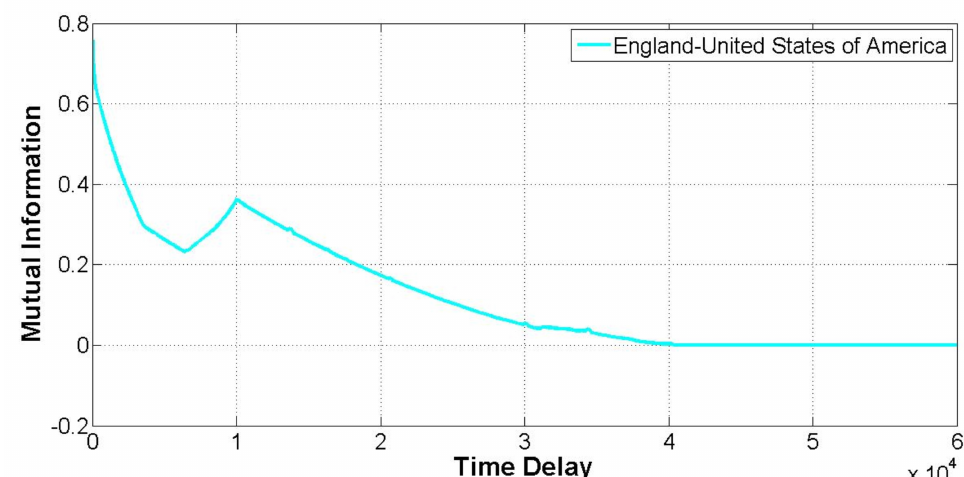
Figure 3. Time delayed mutual information I ( x , x − λ ) for the discrete time series corresponding to the nodes of the network representing the countries of England and the United States of America. As before, the time delay λ is expressed in days ranging from 1 up to approximately 164 years, a value that ensures the statistical independence of the stochastic processes and its delayed versions representing the temporal evolution of the political relationships of the aforementioned countries covering the period from 1816 till